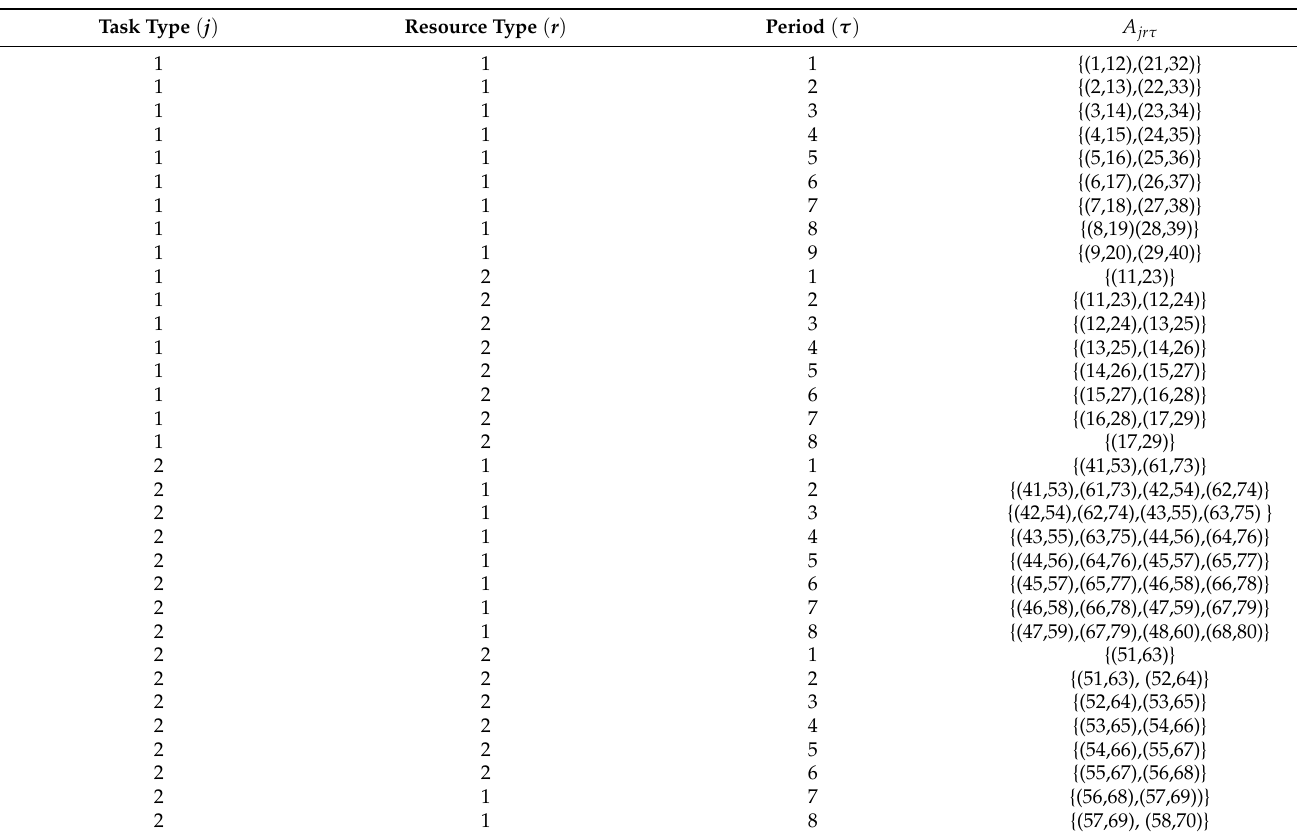
Table 5. The data of A jr τ .